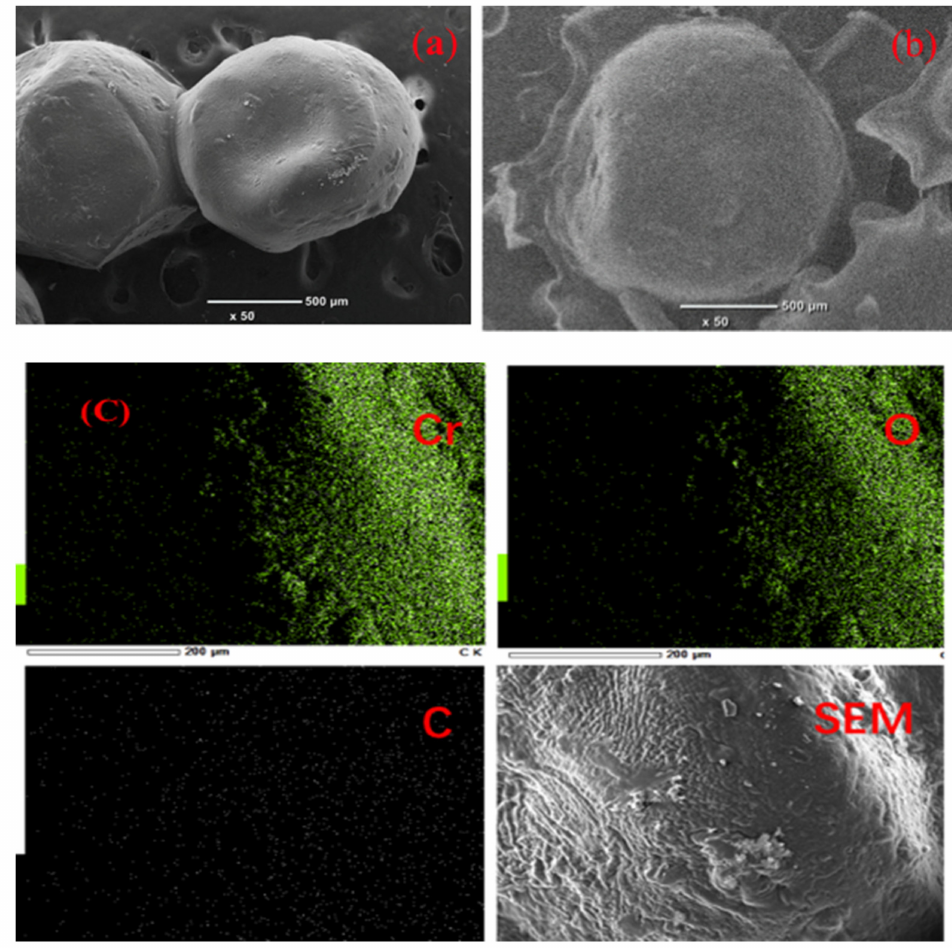
Figure 8. Scanning electron microscopy (SEM) images of ( a ) chitosan beads and ( b ) SDS-modified chitosan beads, and ( c ) mapping image of SDS-modified chitosan beads after the adsorption of